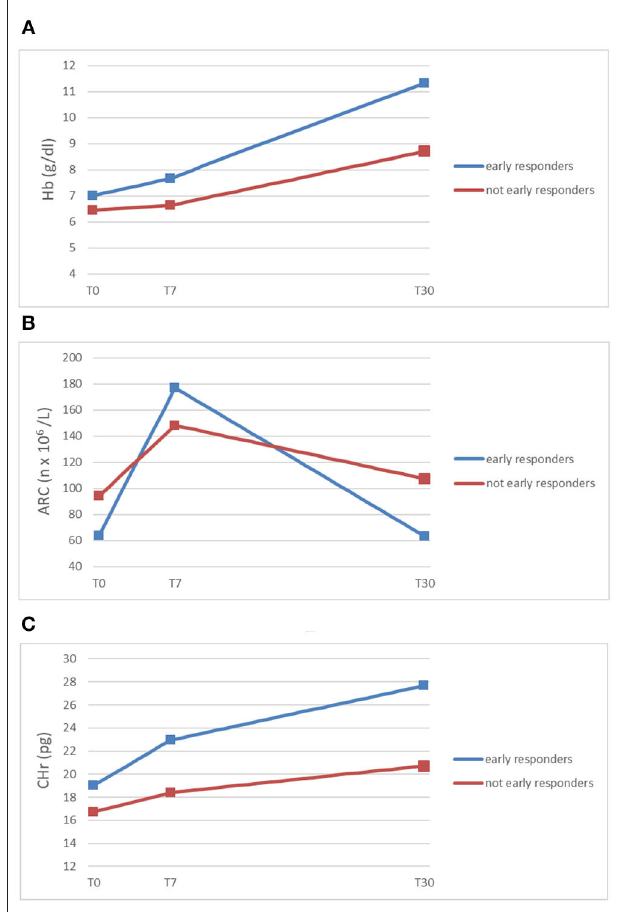
FIGURE 1 | Trends of mean Hb (A) , ARC (B) , and CHr (C) ( y -axis) in early responding patients and not early responding patients at diagnosis (T0), within 7 days from the beginning of oral iron supplementation (T7), and after 30 days (T30) ( x -axis) (5,